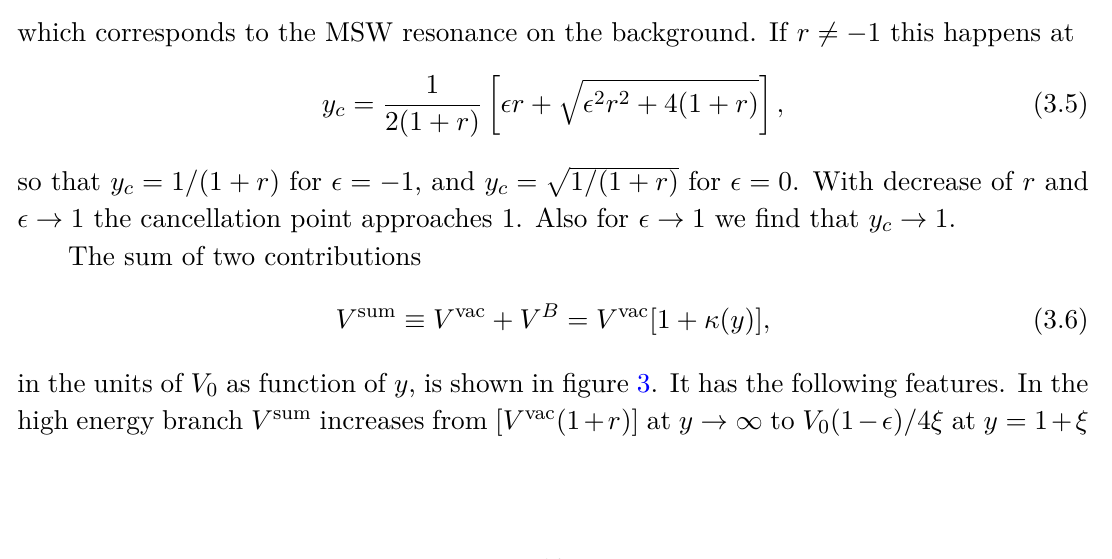
for neutrinos and e /V 0 show the points of the MSW resonances 0